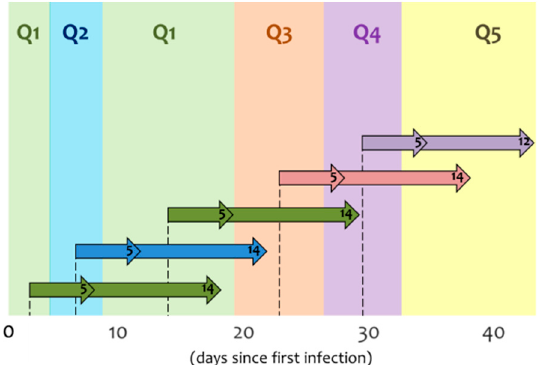
Figure 6. Lengths of the 5-day (on average) up to the 14-day (maximum) time time-lag expressing the time from exposition to the appearance of the symptoms of the disease. These lengths illustrate the ranges where policies included in each period (Q 1 , Q 2 , Q 3 , Q 4 , and Q 5 ) can be effective to the evolution of the infection curve.